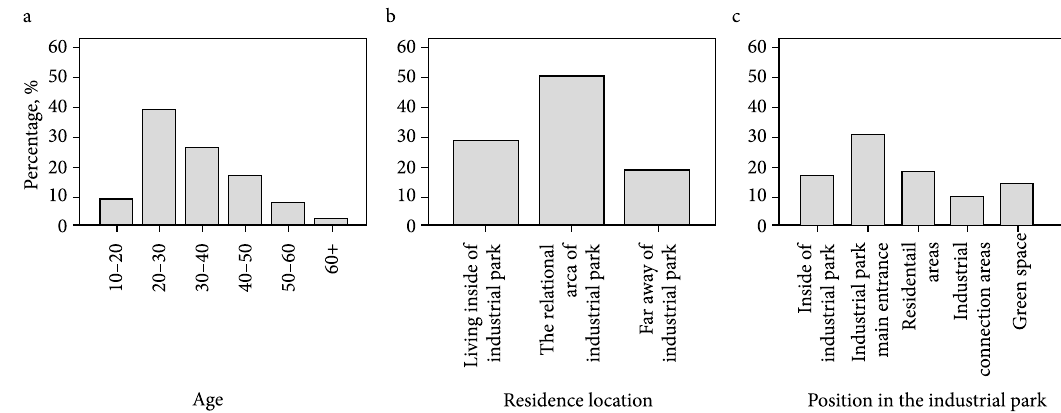
Fig. 4. The distribution of interviewees’ age, residence location, and interview position in the industrial parks